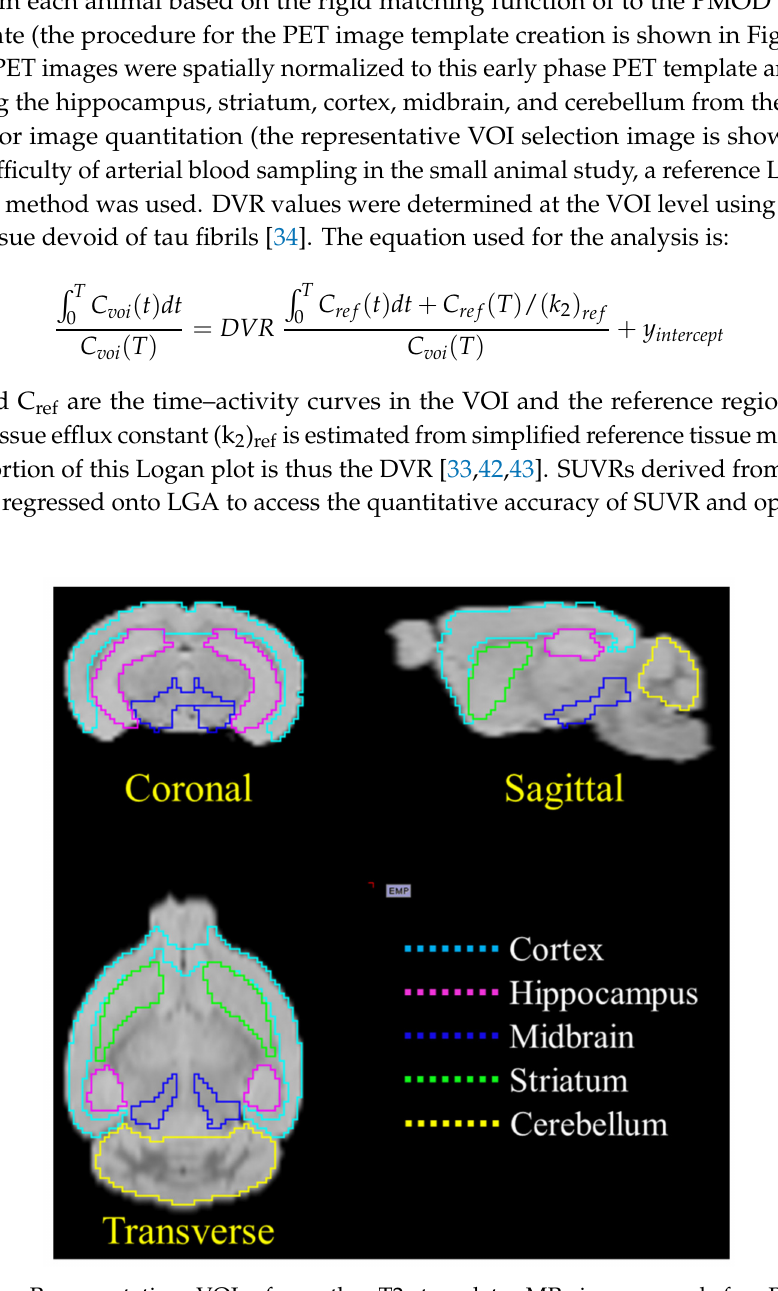
Figure 7. Representative VOIs from the T2 template MR image used for PET image quantification